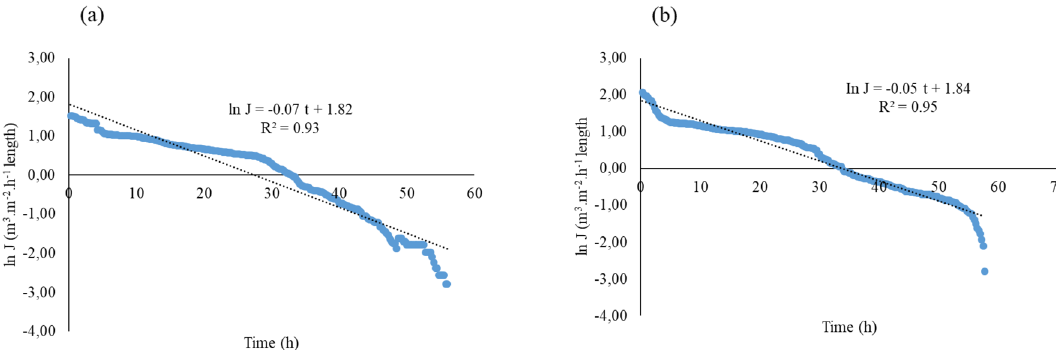
Figure 7. Linearised flux decline rate for ( a ) AF effluent and ( b ) HFCW effluent.